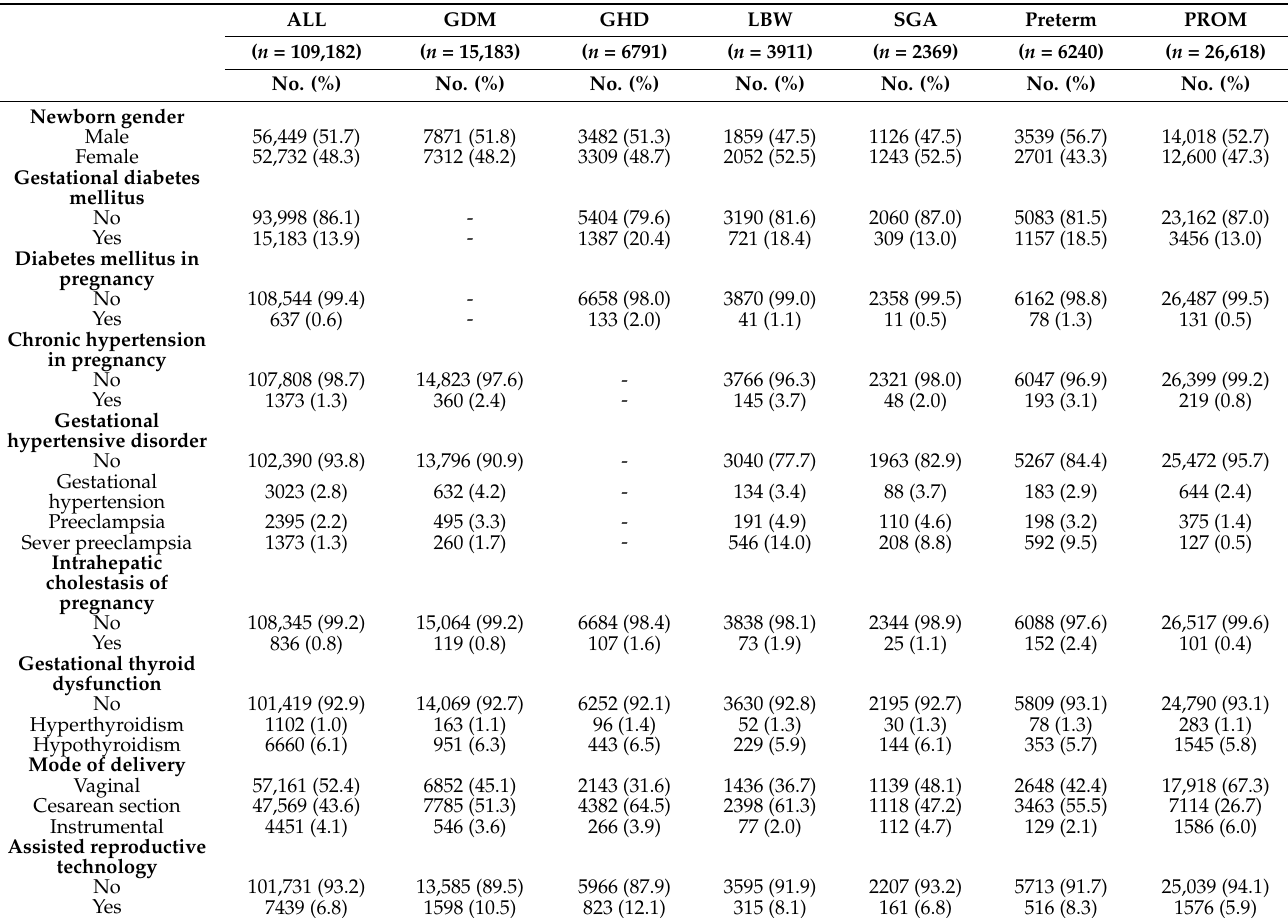
Table 2. Gestational complications of all pregnant